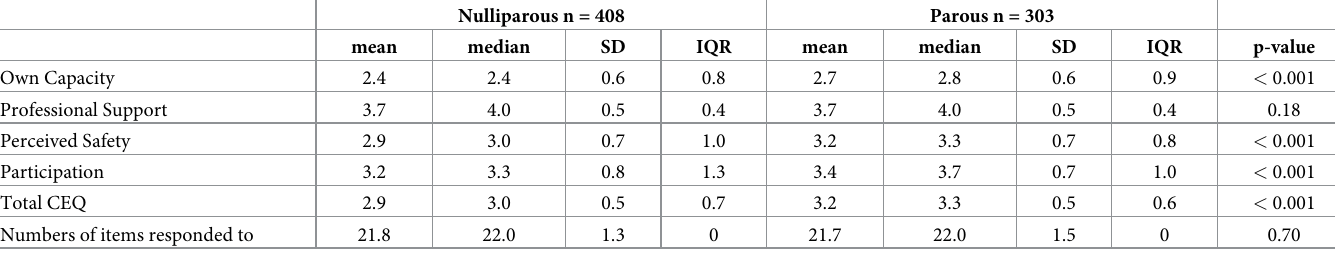
Table 3. Childbirth experience questionnaire (CEQ) domain scores (N =